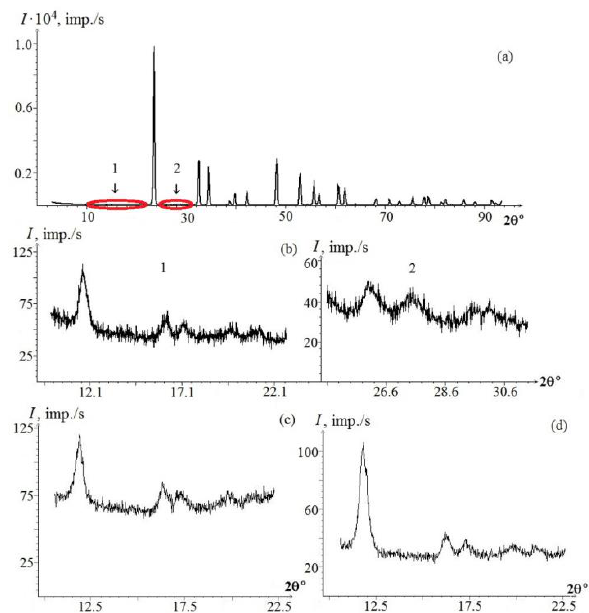
Figure 22. ( a ) X-ray diffraction pattern of the crystal LiNbO 3 :Er (0.062 mol.% Er 2 O 3 ), areas of additional reflections are marked in red circles; ( b ) Additional weak reflections on an enlarged scale from marked areas on (a); ( c ) Additional reflections on X-ray pattern of a CLN crystal; ( d ) Additional reflections on X-ray pattern of a crystal LiNbO 3 :Zn (6.52 mol.% ZnO, homogeneous doping). Table 4. 2 θ scattering angles for additional reflections and the interplanar spacings of CLN and LiNbO 3 :Er calculated from them. Crystal